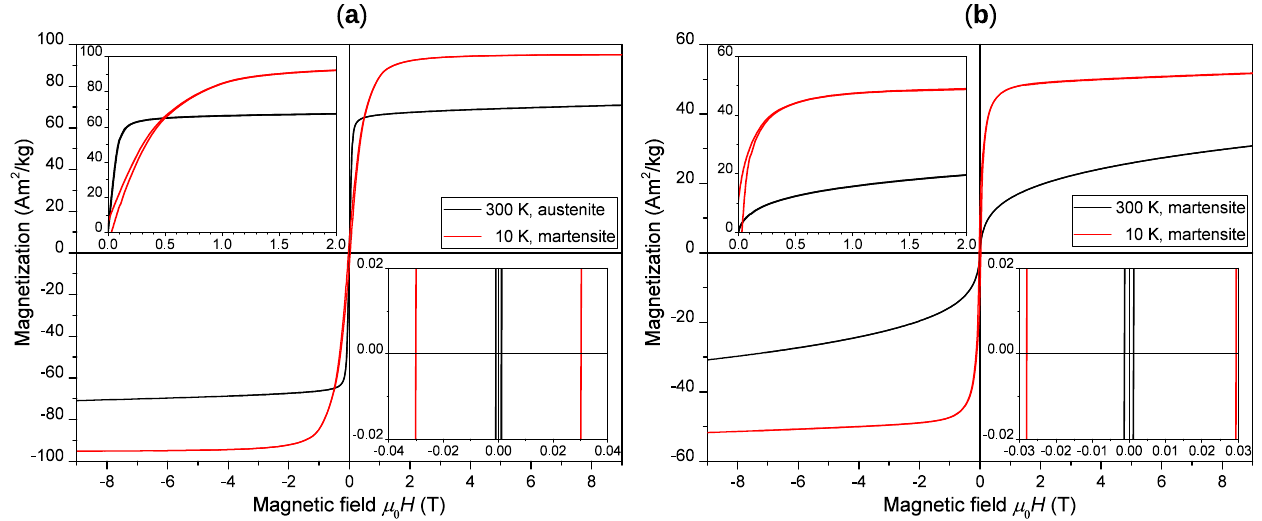
Figure 1. Isothermal magnetisation curves of ( a ) (Ni 45.0 Ni 5.4 )Mn 24.6 Ga 25.0 and ( b ) Ni 49.9 Mn 24.6 (Ga 20.4 Co 5.1